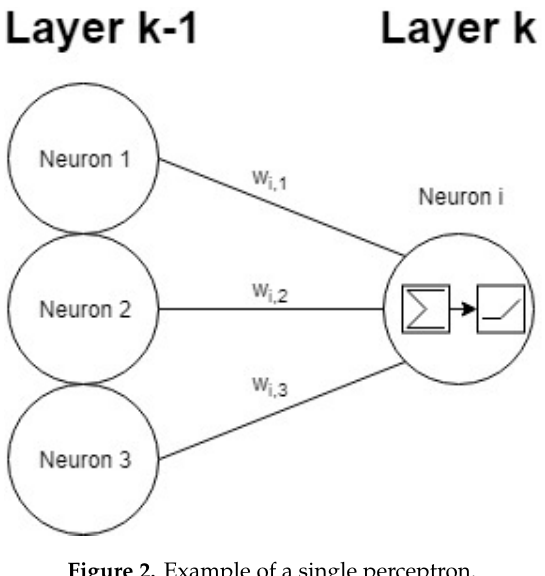
Figure 2. Example of a single perceptron.